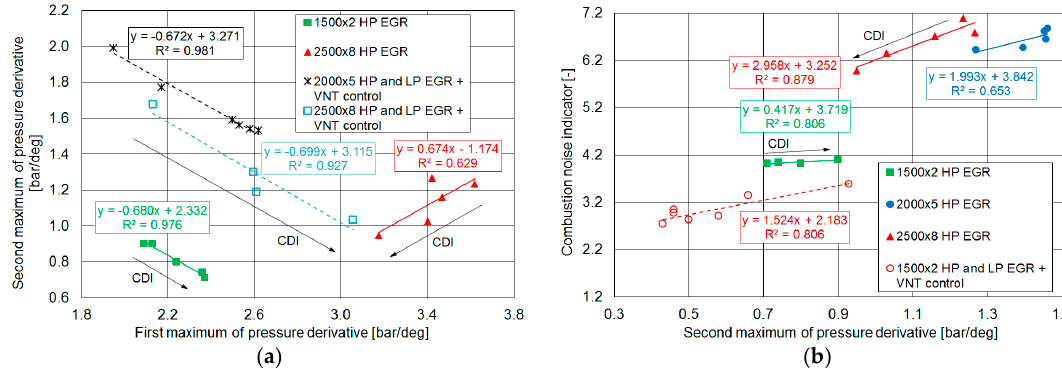
Figure 12. Link between first and second maximum of pressure derivative ( a ) and second maximum of pressure derivative and combustion noise indicator; ( b ) in different test sets.